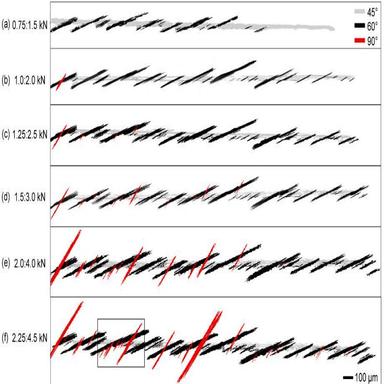
(a–f) Evolution of fracture surfaces during each in-situ inspection interval. Inset box shown in (f) defines the crack network examined in Fig. 9.